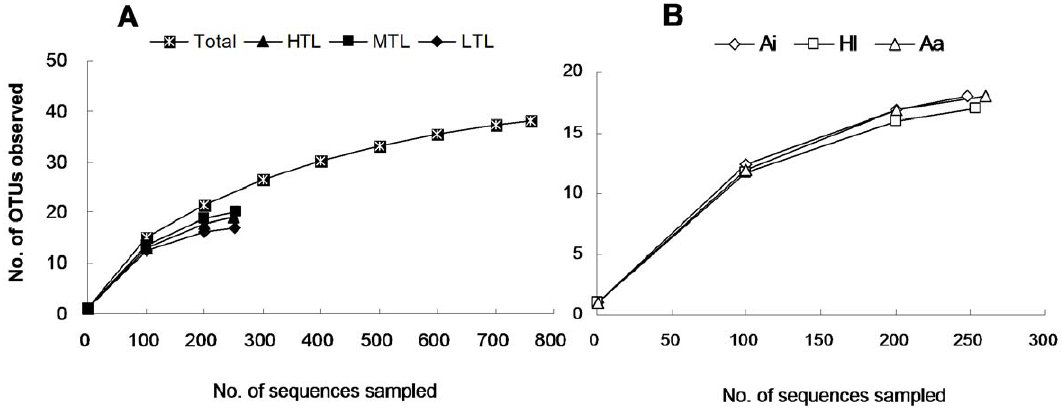
Figure 2. Rarefaction curves showing the sequences sampling effort of this study. ( A ) Rarefaction curves of the total number of sequences, sequences sampled from low, middle and high tide levels (LTL, MTL and HTL) and ( B ) Acanthus ilicifolius , Heritiera littoralis and Acrostichum aureum (Ai, Hl and Aa) at an operational taxonomic unit (OTU) threshold level of 97% sequence similarity.